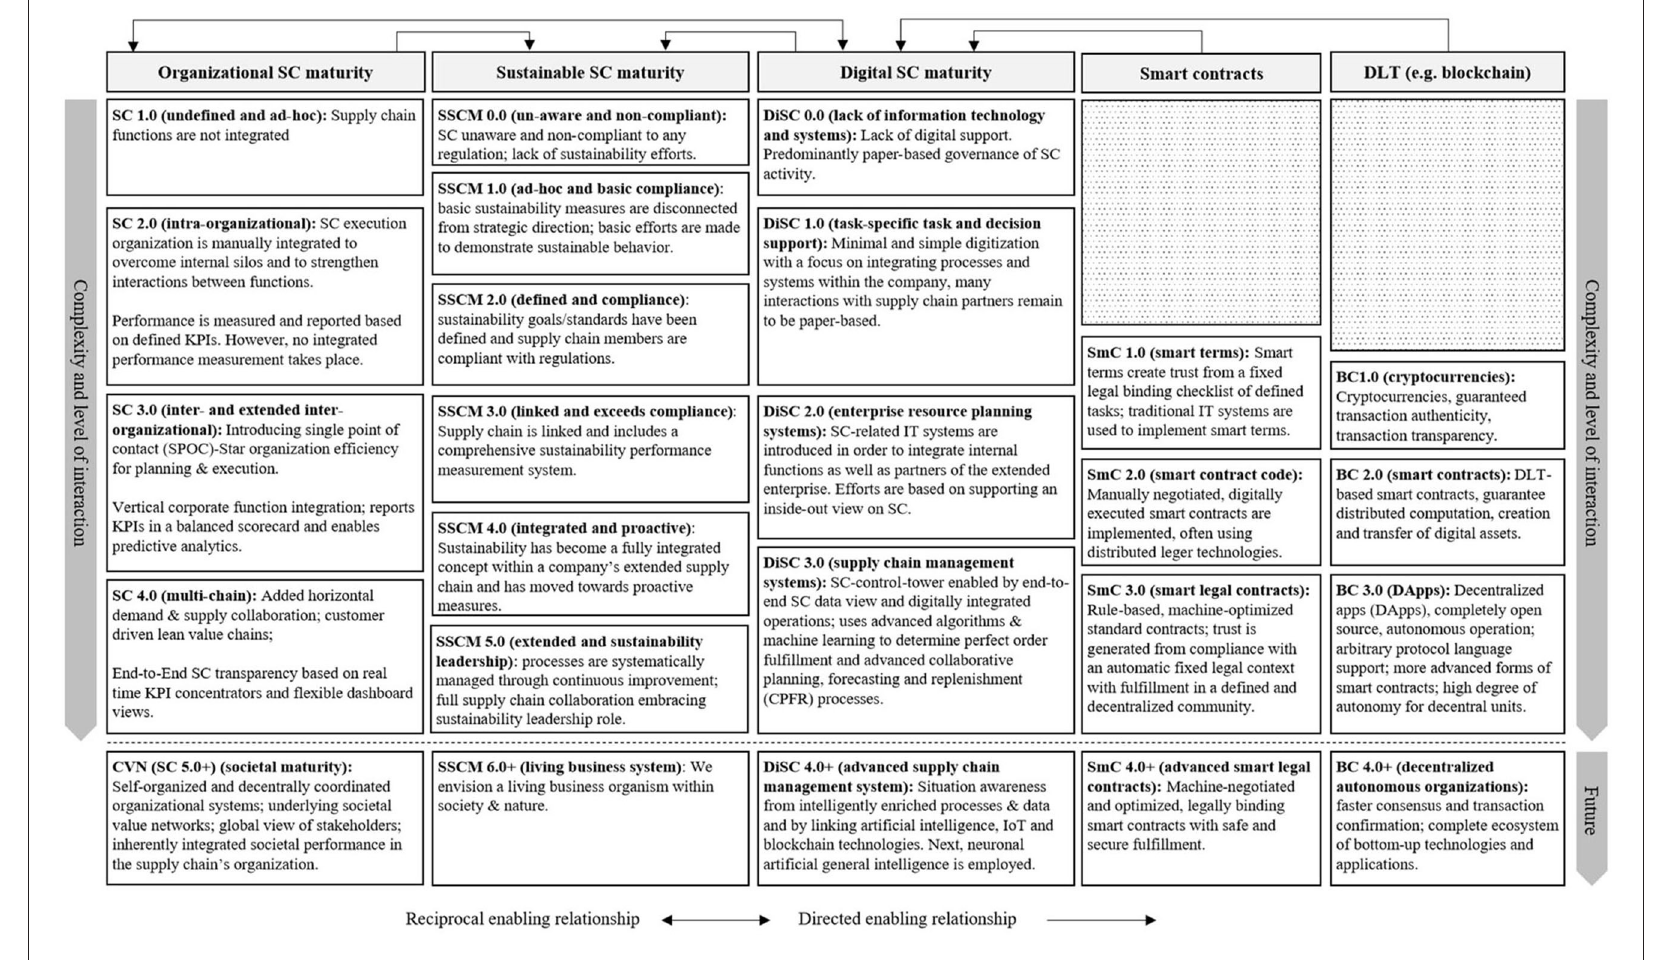
FIGURE 4 | Integrated view of organizational, sustainable, and digital supply chain maturity considering smart contract and blockchain